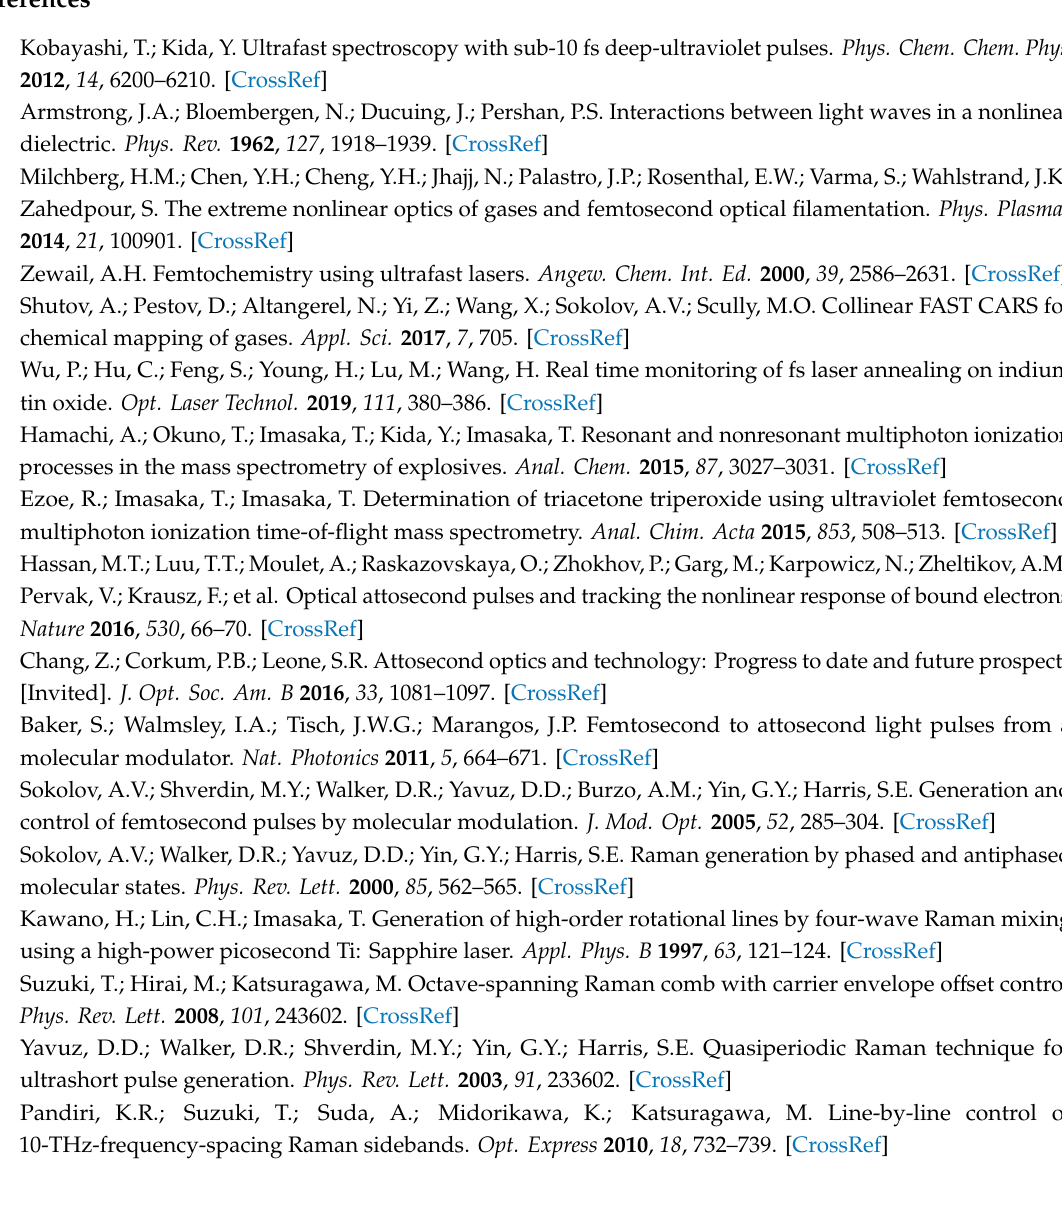
Figure S1: The optical path variation by rotating a pair of BK7 glass